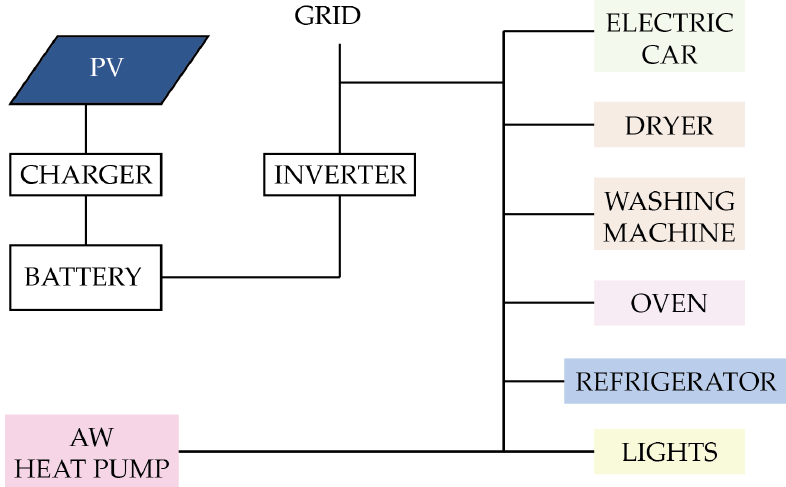
Figure 2. Typical loads in residential buildings with PV system.